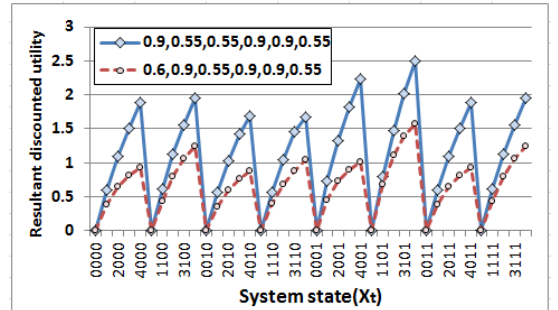
Figure 6. Variation of resultant discounted utility with system state for different combinations of probability values related to remaining battery power L t , event generation P ( p on , p of f ), packet transmission rate ( pr on , pr of f ) and link quality ( lq on , lq of f ) .